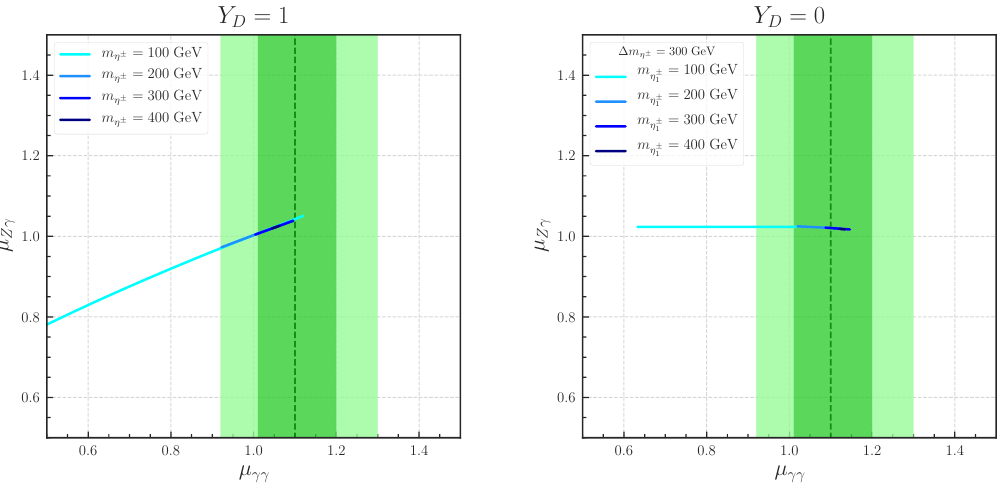
Figure 12 . Correlation between (cid:22) Z(cid:13) and (cid:22) (cid:13)(cid:13) in the model with Y D = 1 (left) and Y D = 0 (right) under the constraints of perturbative unitarity and vacuum stability. The dark (light) green band shows the current global average of (cid:22) (cid:13)(cid:13) with 1 (cid:27) (2 (cid:27) ) uncertainty. For Y D = 0, we take ( m (cid:17) ; m (cid:17) ; (cid:18) ) = (80 GeV ; 200 GeV ; (cid:25)= 4), and the mass splitting between the two charged scalar H A bosons is (cid:12)xed to be 300